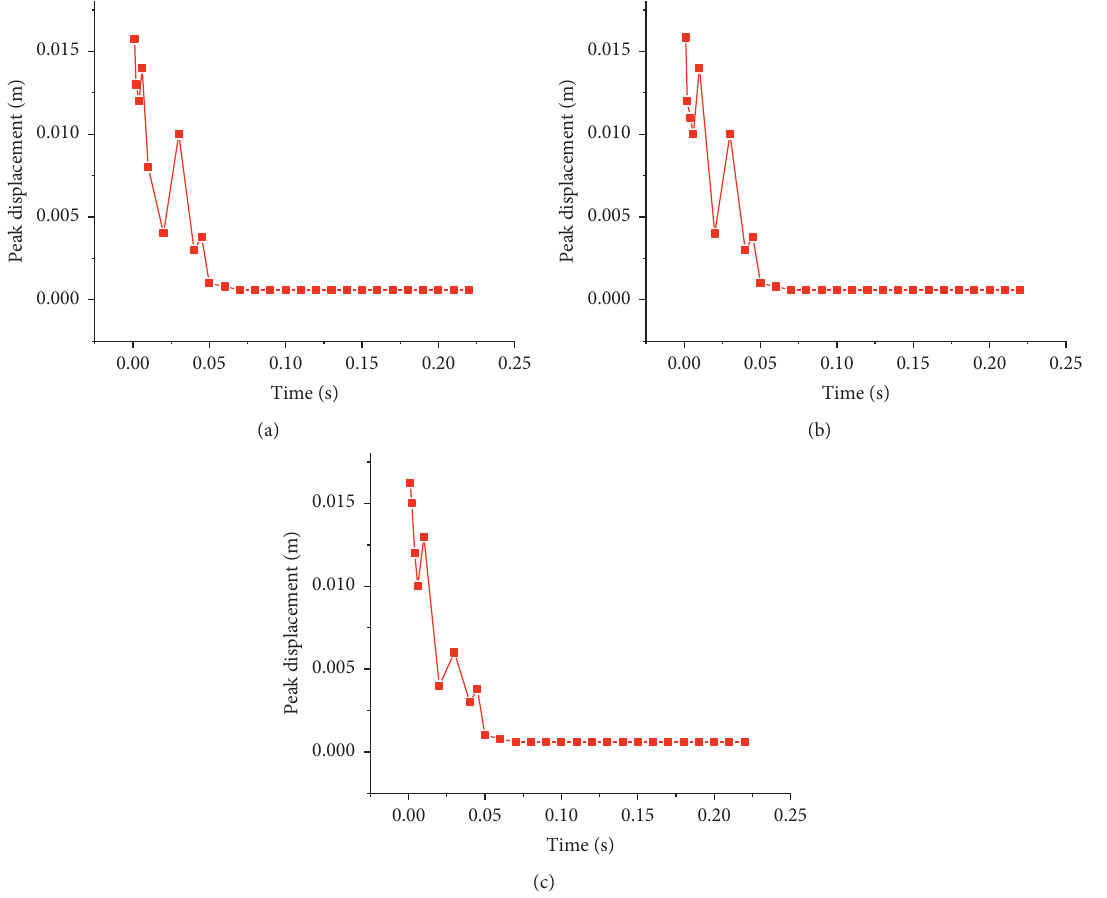
Figure 10: Displacement change of the arch bottom measuring point at 1-1 profile. (a) Third blast. (b) Fourth blast. (c) Fifth blast.